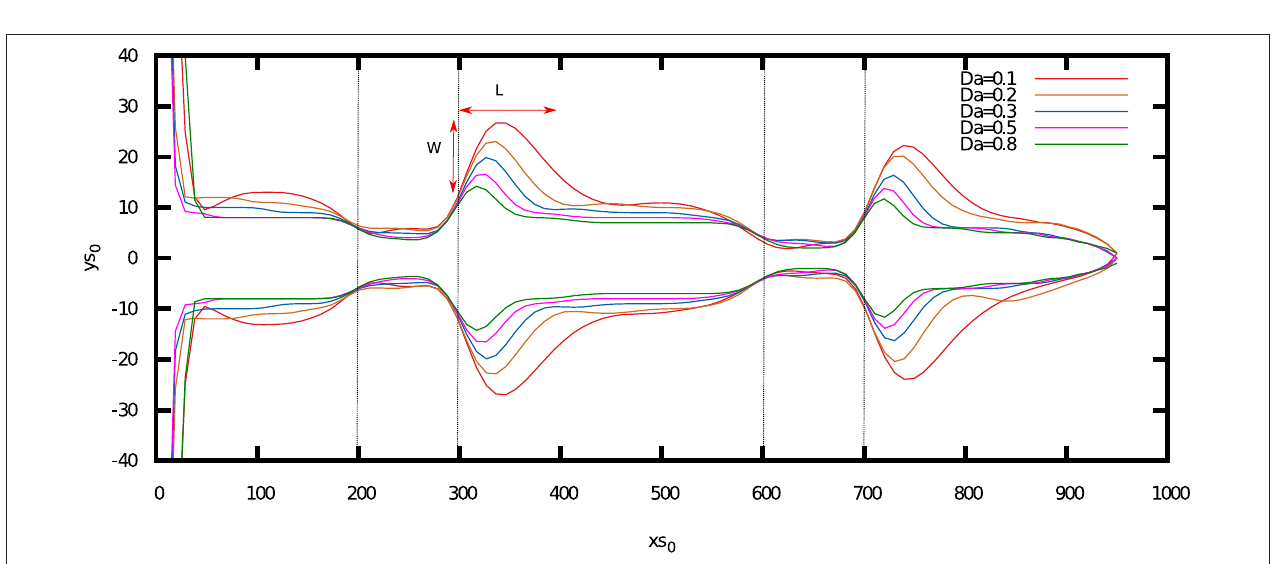
FIGURE 14 | Piping patterns for different Damkölher numbers for a stratification with a porosity contrast of C = 10 . The aspect ratio of the plot has been altered to better visualize